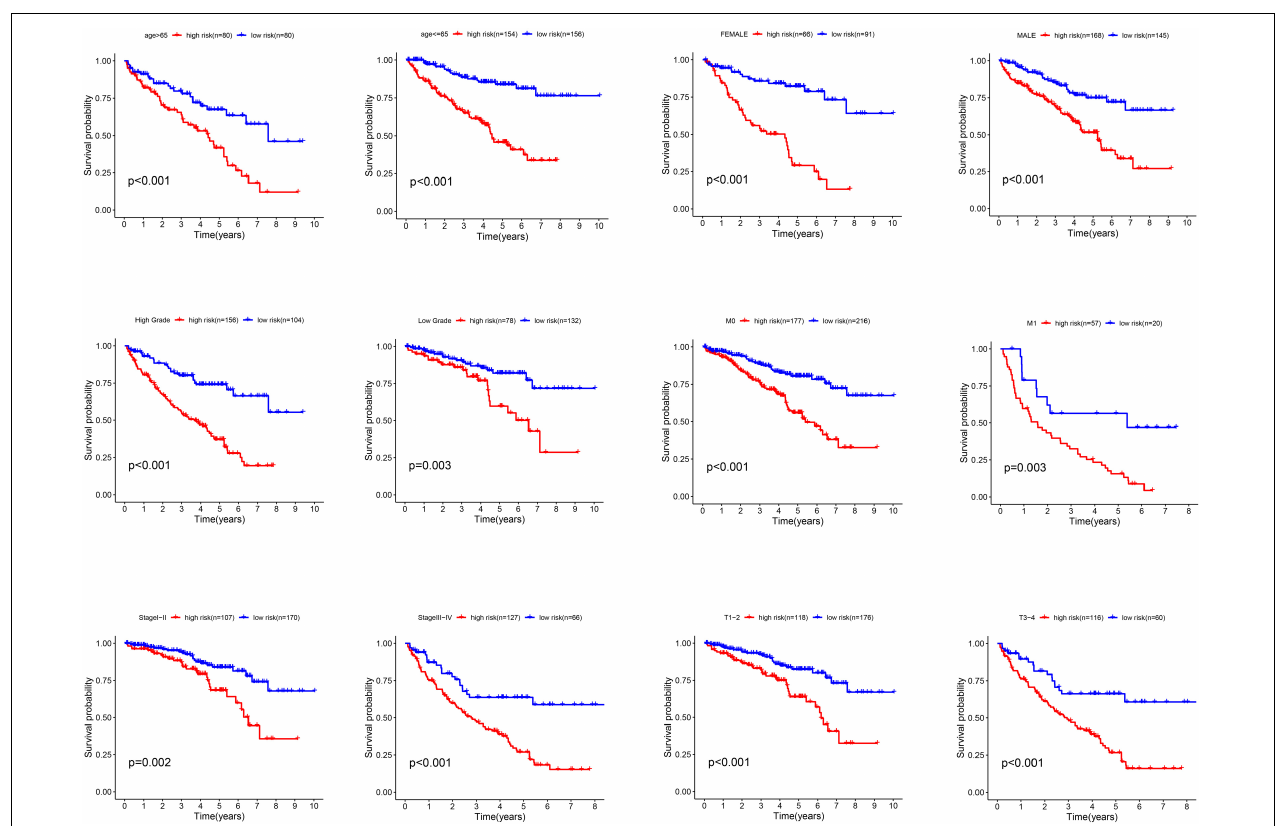
FIGURE 4 | The different survival time of high- and low-risk groups classified by clinicopathological parameters. The Kaplan-Meier survival curve analysis shows that the correlation of risk score and OS among the patients with different characteristics such as age > 65 or age < 65, female or male, high grade or low grade, metastasis or non-metastasis, advanced-stage (Stage III–IV) or early stage (Stage I–II) and T1-2 or T3-4.